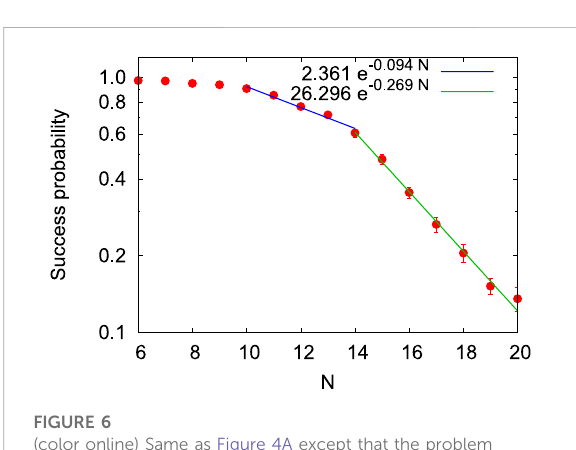
FIGURE 6 (color online) Same as Figure 4A except that the problem instances belongs to the 2SAT